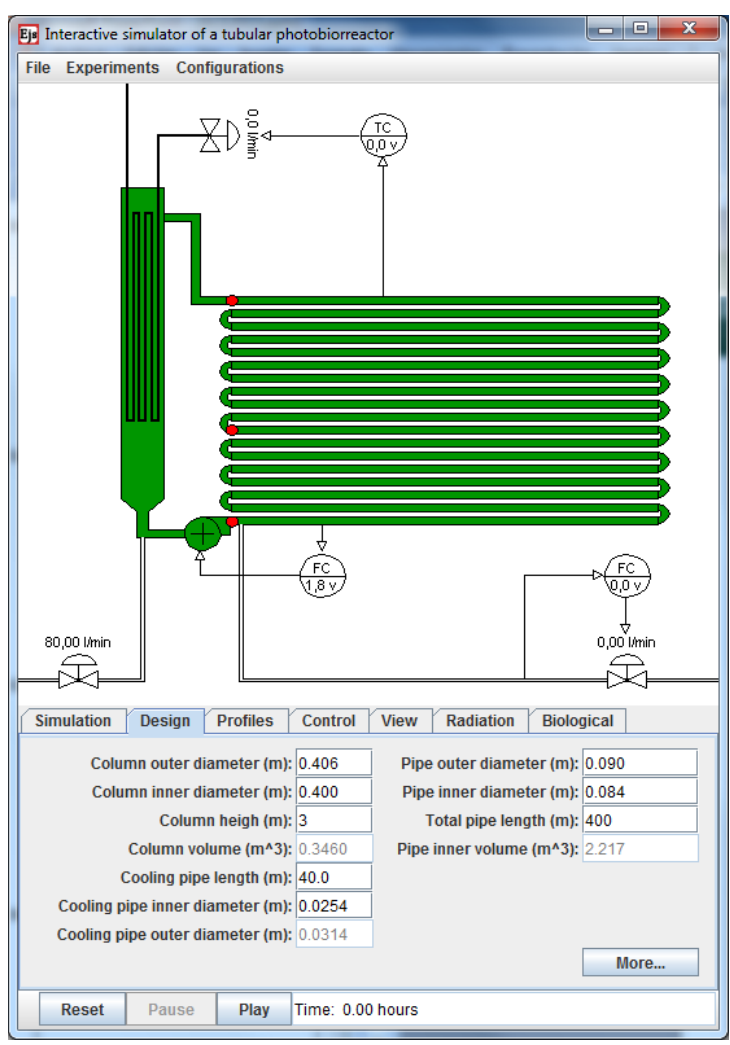
Figure 4. Graphical user interface of the PRB